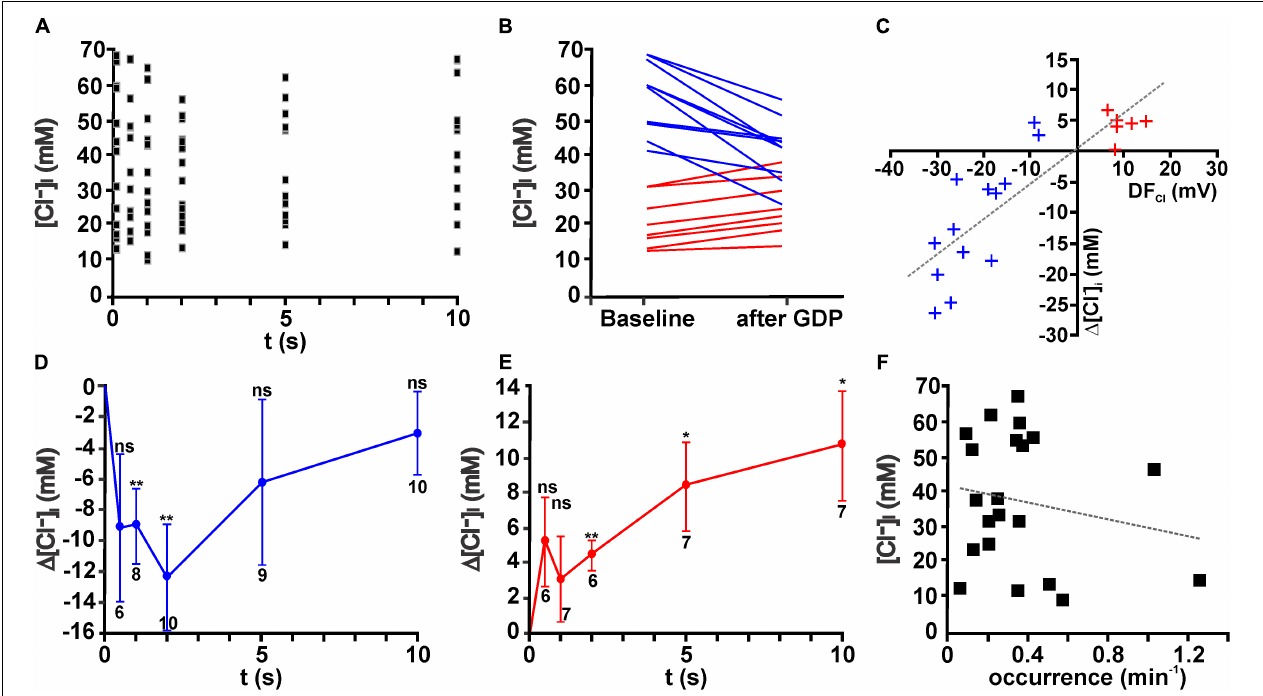
FIGURE 4 | Giant depolarizing potentials lead to substantial [Cl − ] i changes. (A) Scatter plot of [Cl − ] i determined at given intervals after a GDP in 19 neurons. Note that the [Cl − ] i values tend to decrease between 1 and 5 s. (B) [Cl − ] i of individual neurons at baseline conditions and 1–2 s after a GDP. Note the obvious alteration in [Cl − ] i . Cells that respond with a [Cl − ] i increase are represented by red lines and [Cl − ] i decreases by blue lines. (C) Plot of the GDP induced [Cl − ] i change ( (cid:49) [Cl − ] i ) against the estimated driving force (DF Cl ) for individual neurons. Blue symbols represent cells with a negative DF Cl , red symbols cells with a positive DF Cl . Note the obvious correlation between both values. (D) Average [Cl − ] i changes observed at different intervals after GDP termination for all cells with a negative DF Cl . In these neurons a significant [Cl − ] i decrease occurs that peaked 2 s after GDP termination. (E) Average [Cl − ] i changes observed at different intervals after GDP termination for all cells with a positive DF Cl . In these neurons a significant [Cl − ] i increase occurs. (F) Plot of [Cl − ] i against the frequency of GDPs. No significant correlation between both values was detected. Data points in (D,E) represent mean ± SEM, numbers of experiments are given in the diagrams, ∗ indicates a p -level of < 0.05 and ∗∗ indicates a p -level of <